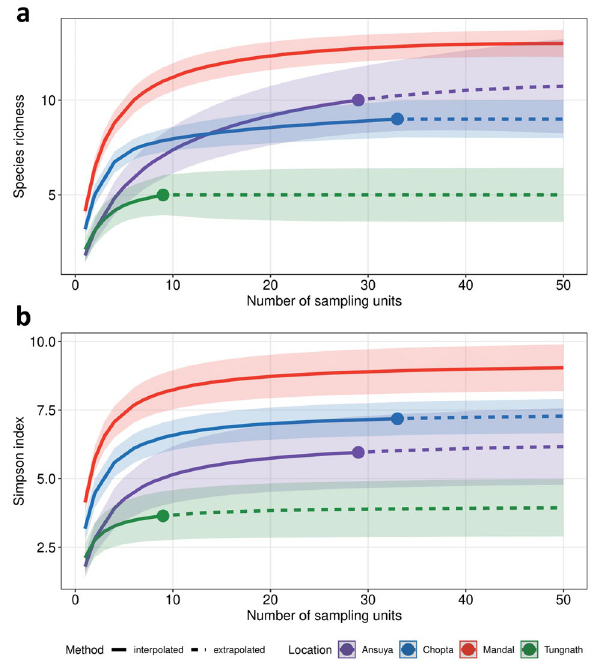
Figure 3. Rarefaction curves of ( a ) cumulative species richness and ( b ) Simpson diversity across all elevational communities plotted against the number of sampling nights. Each location is represented by a different colour. The symbols represent the number of sampling nights at each location. Species richness of all locations is extrapolated to the number of sampling nights at Mandal (shown by the dotted